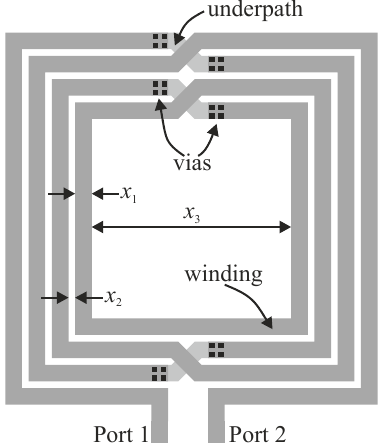
Figure 4. Layout of the four-turn integrated on-chip inductor.